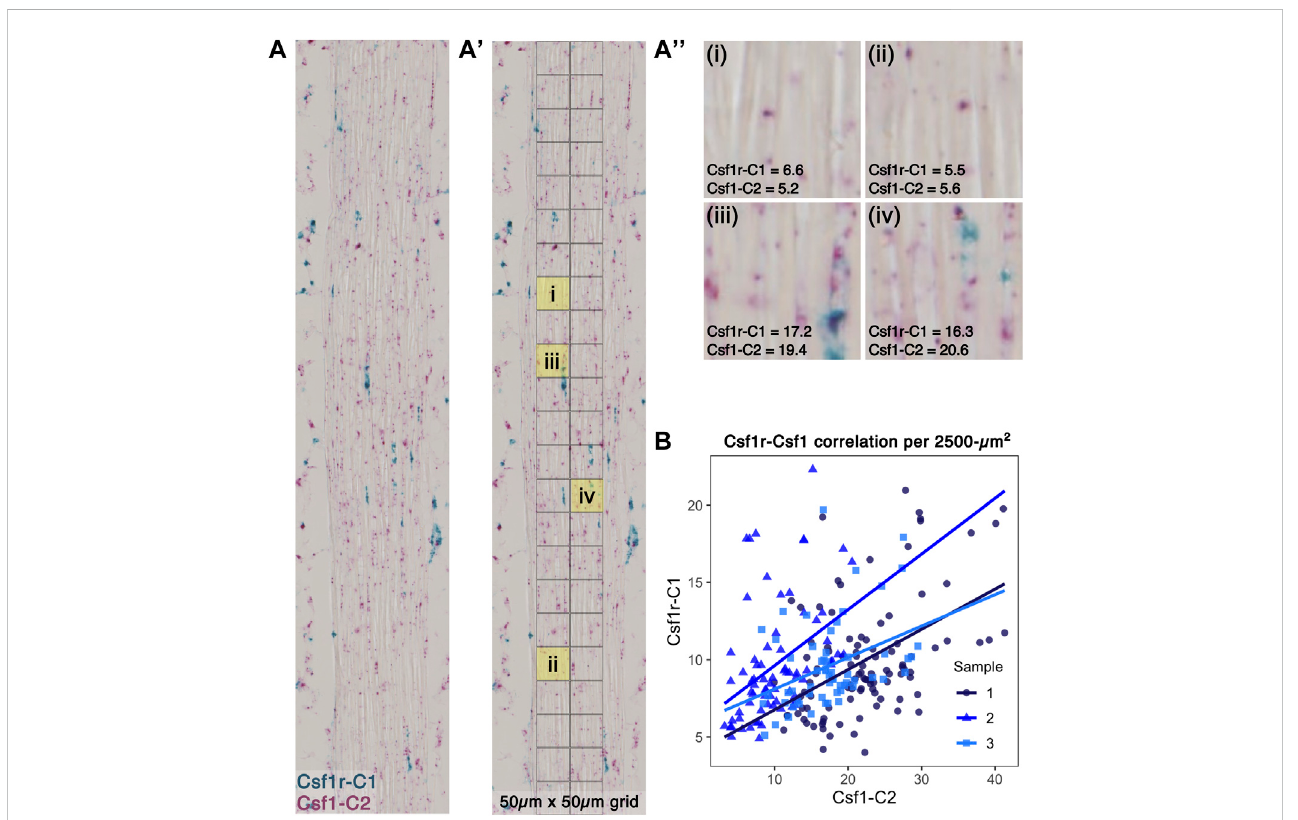
FIGURE 6 Csf1r -expressing macrophages localize to Csf1 -expressing tendon fi broblasts (A) Representative image of RNAScope ISH of Csf1 and Csf1r RNA on P28 patellar tendon sections. Scalebar =20 µm (A ’ ) Each ISHimagewasdivided intoa50 μ m ×50 µmgridto quantify average staining intensity of eachstain per unit area (A ’’ ) Representative 2,500-µm 2 units with corresponding Csf1r-C1 and Csf1-C2 mean intensity measurements (low expression in upper row and high expression in lower row) (B) Scatter plot showing average intensity of Csf1r-C1 and Csf1-C2 staining within each unit area ( n =